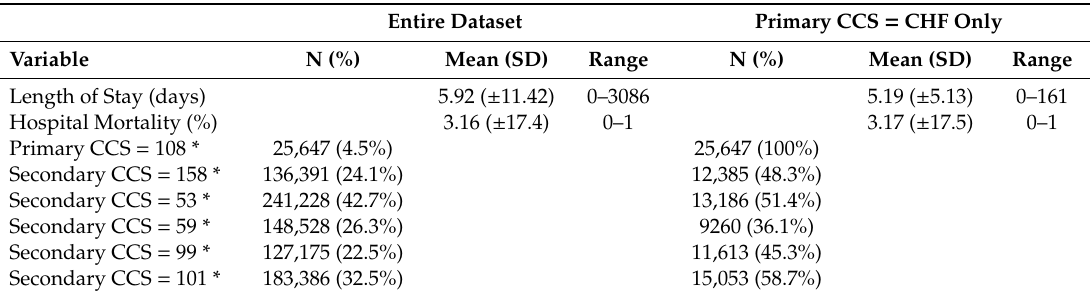
Table 1. Descriptives for the entire dataset (left), and for target dataset with congestive heart failure (CHF) cases